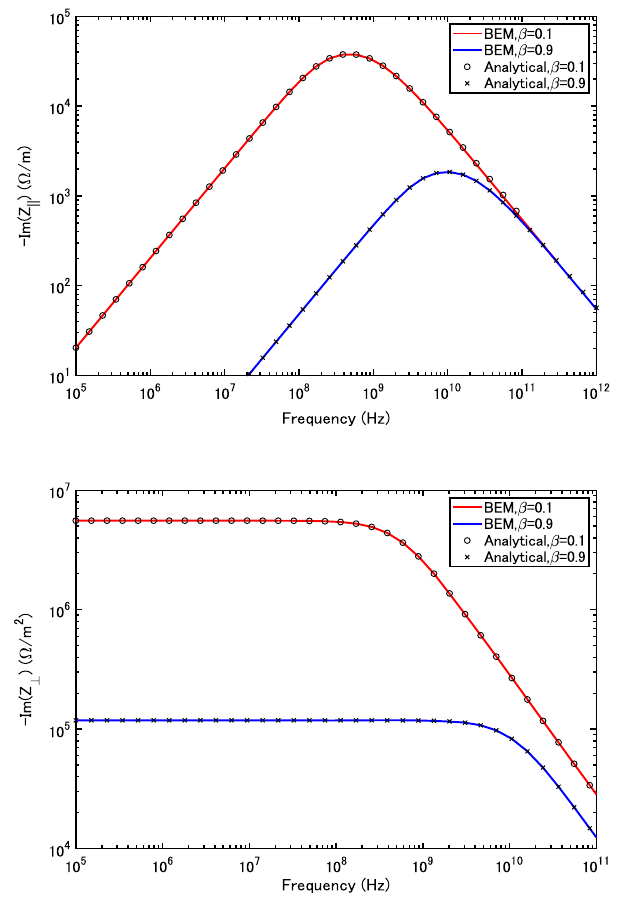
FIG. 4. Comparison of numerical (BEM) and analytical (refer- ence) space charge impedances for a uniform cylindrical beam with radius r b ¼ 1 cm and a PEC round vacuum chamber with radius b ¼ 4 cm. Top: longitudinal. Bottom: